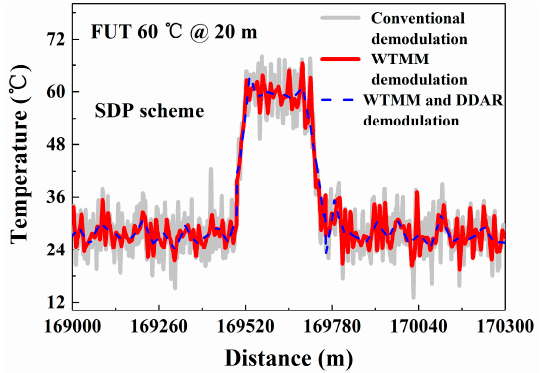
Figure 13. Temperature measurement results of FUT.